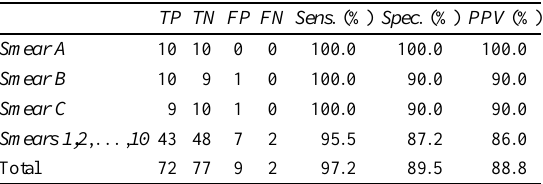
Comparison of the results obtained by the proposed algorithm with the manually classified by a human expert